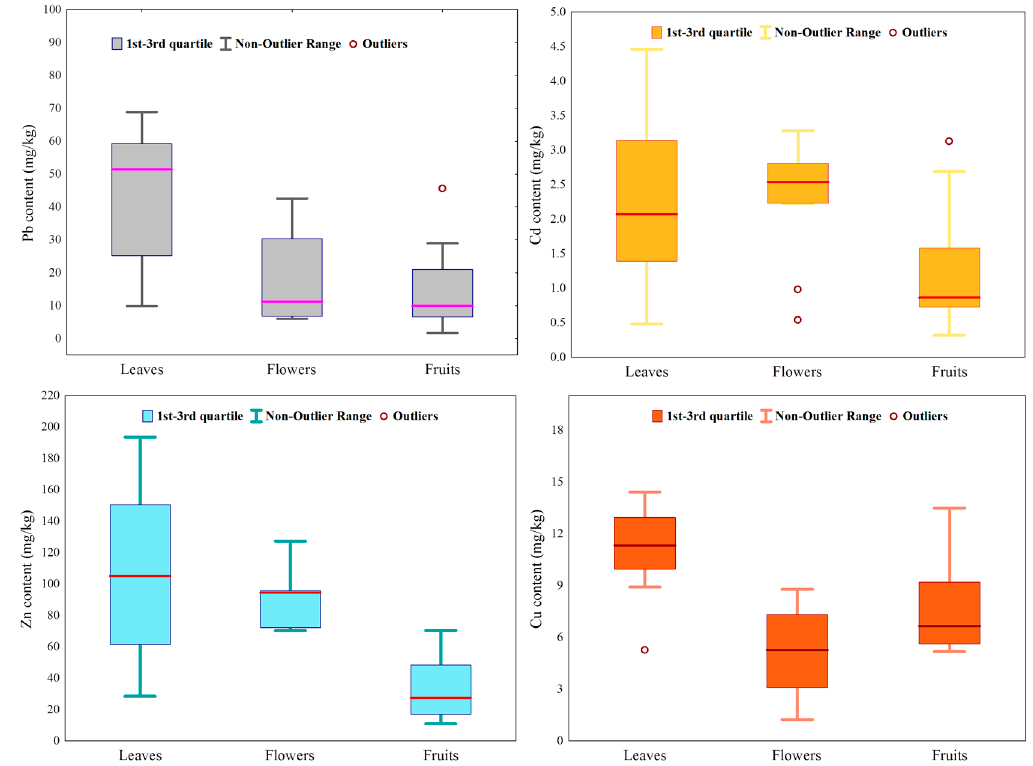
Figure 2. The stratification of heavy metal content according to the sampled blackberry organs.